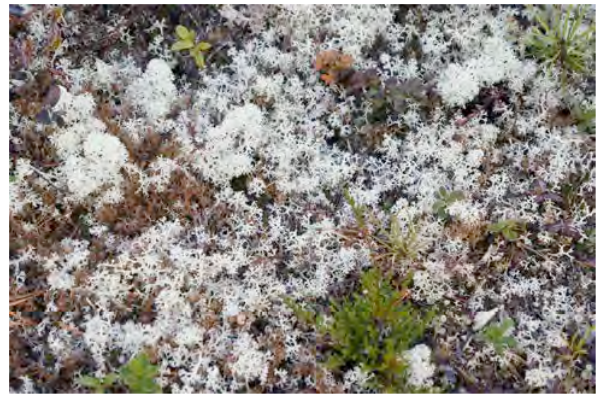
Figure 14. View of about 1m 2 of the snow-free surface at the ra- diometer test site in Sodankylä, Finland.